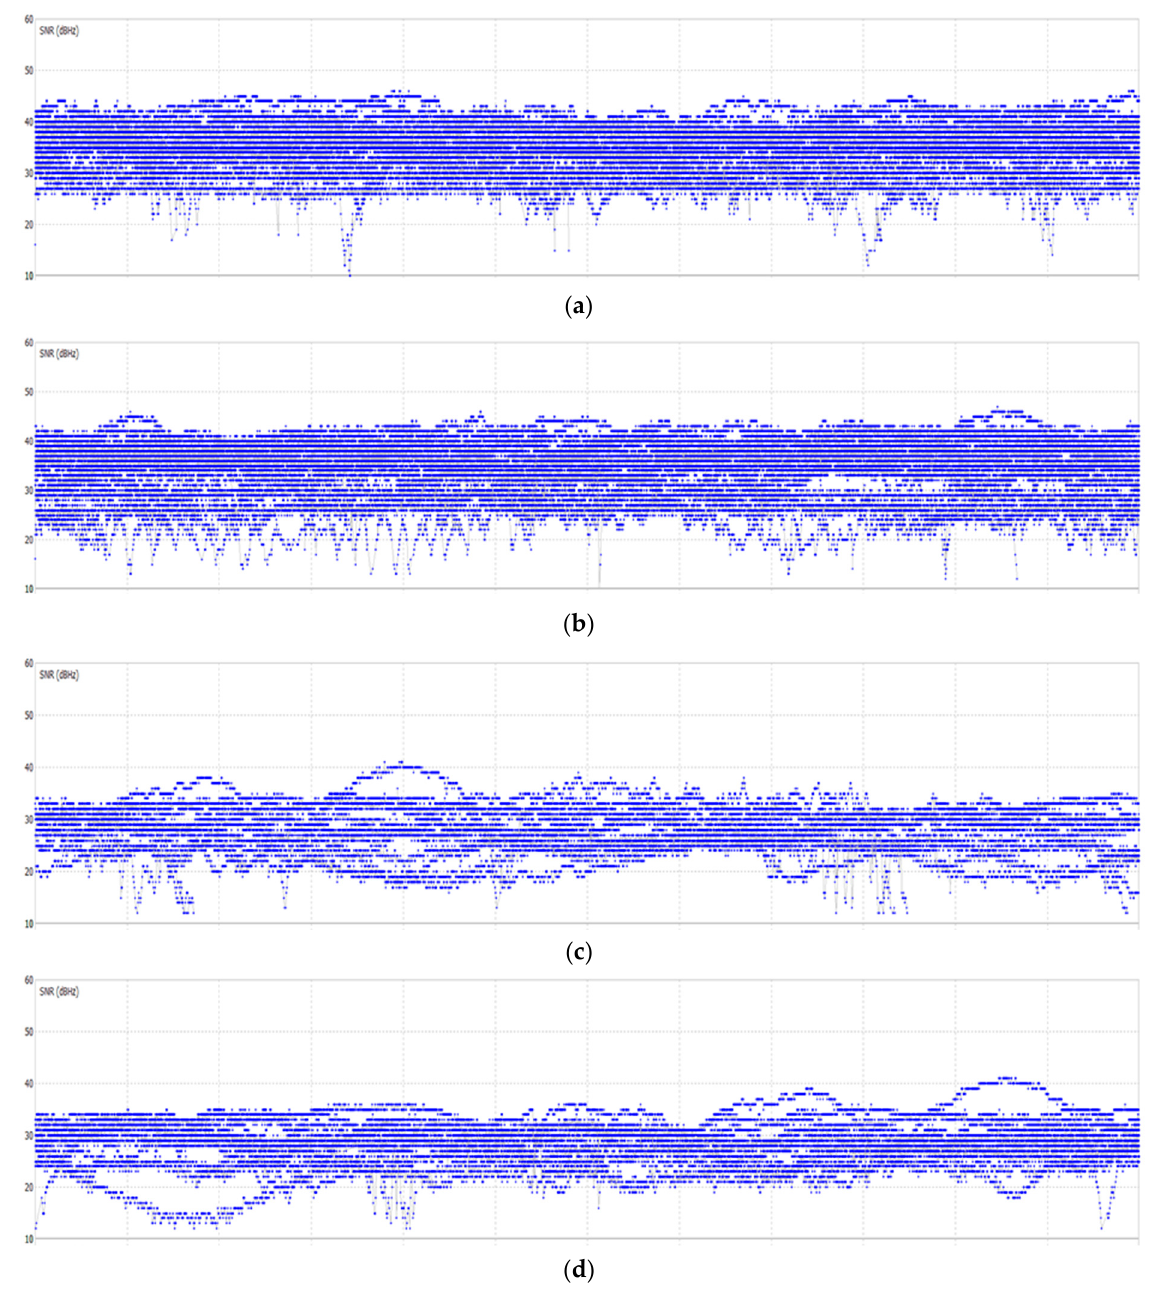
Figure A3. For the Huawei P30 Pro: ( a ) best SNR for L1; ( b ) worst SNR for L1; ( c ) best SNR for L5; ( d ) worst SNR for L5.